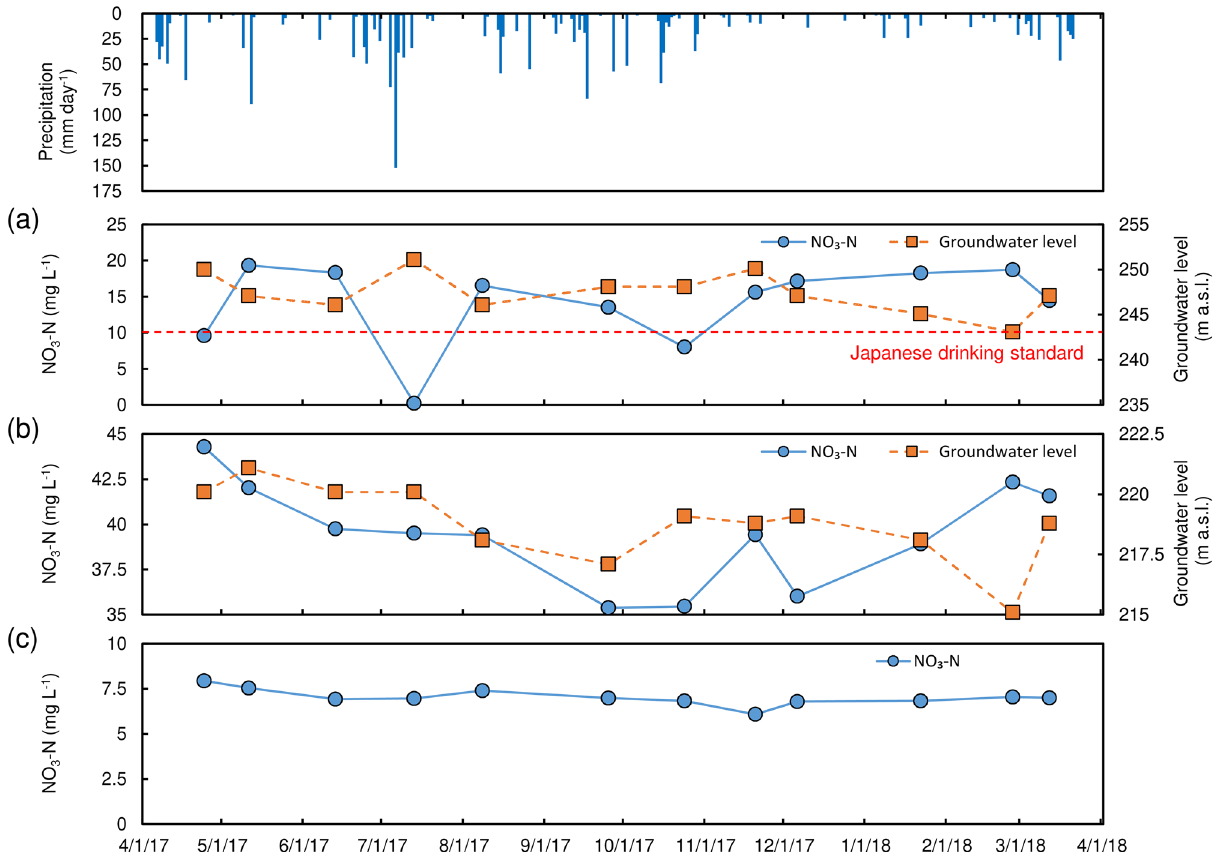
Figure 4. Temporal variation of precipitation, nitrate concentration in groundwater, and groundwater level ( a ) T-1, ( b ) T-2, ( c )